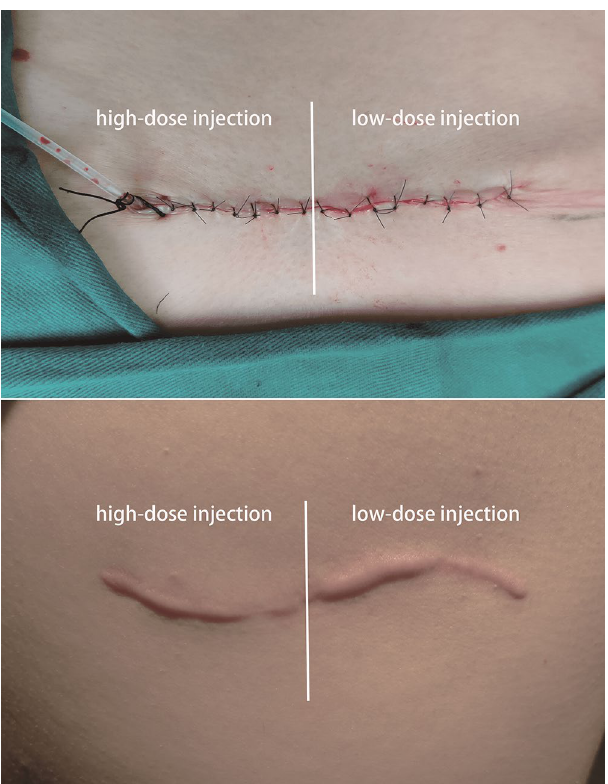
Figure 2. Right back scar at baseline ( above ) and at 6-month follow-up ( below ). The right half of the scar was treated with high-dose botulinum toxin type A (BTxA) and the left half was treated with low-dose